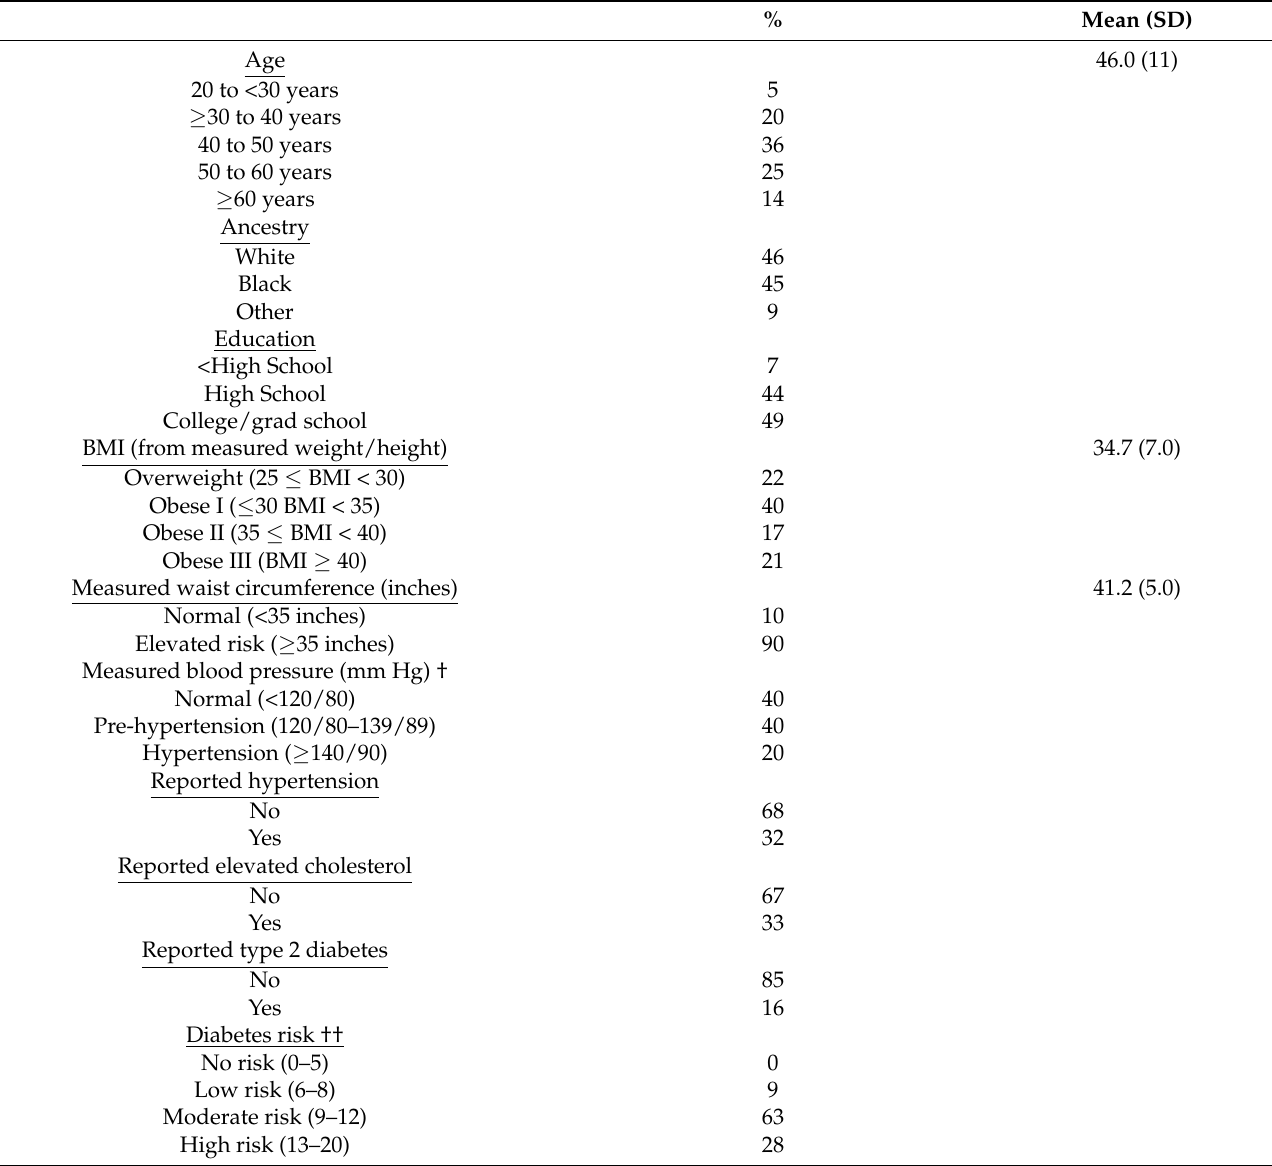
Table 1. Demographic and health variables of female employees from four long-term care facilities ( n =